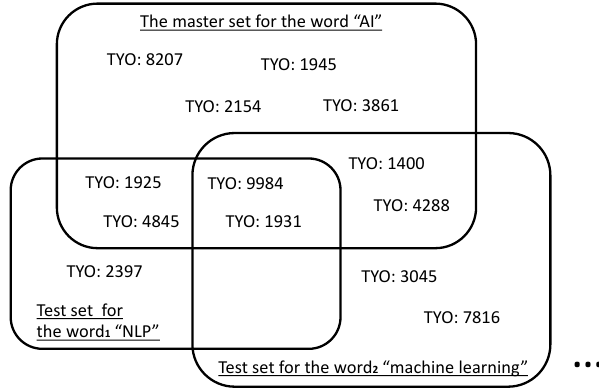
Figure 2. s 2, word calculation. “TYO: xxxx” means the ticker code of the companies on the i = 4/5 = 0.8 and s = 4/6 = Tokyo Stock Exchange. Here, s 2, word 2, word 2 1